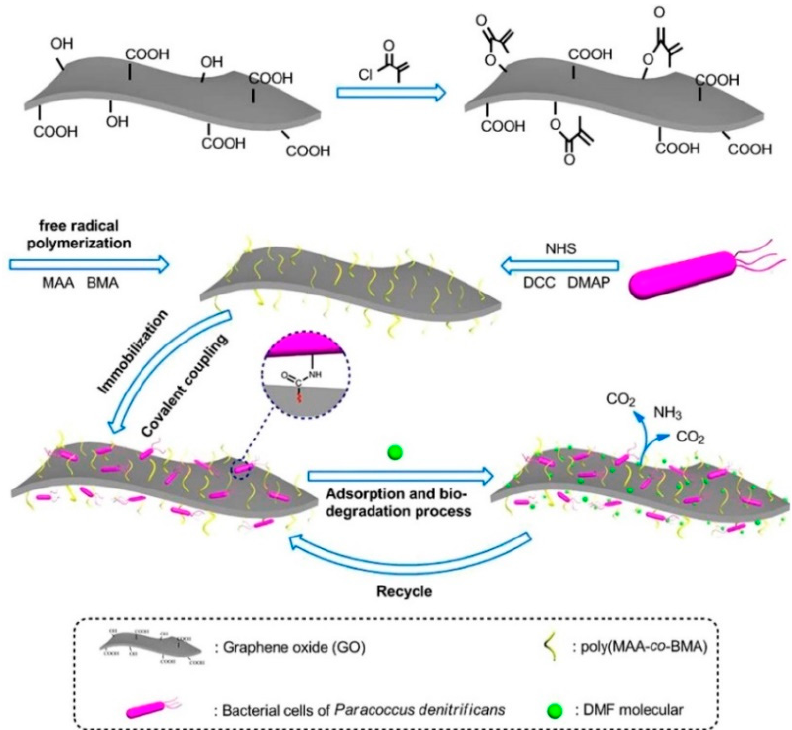
Figure 3. Schematic diagram of PGO synthesis and the adsorption-biodegradation process of the N , N -dimethylformamide (DMF) molecular on bacterial cells immobilized PGO. Reproduced from [134], with permission from Nature Publishing Group,